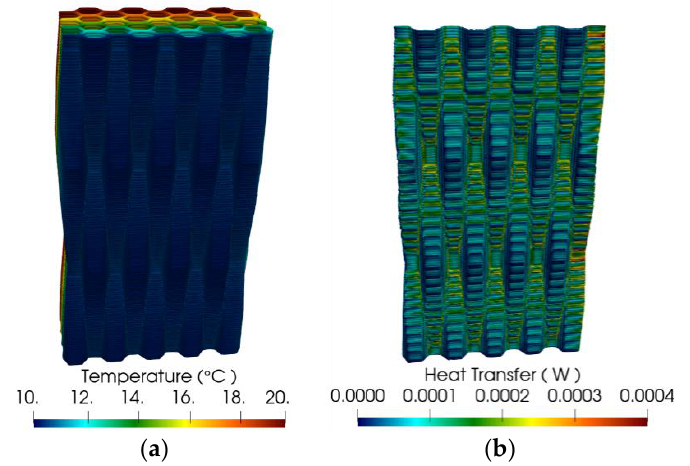
Figure 12. Three-dimensional simulation results on the optimized geometry showing ( a ) the temper- ature field and ( b ) the heat flux on the outer